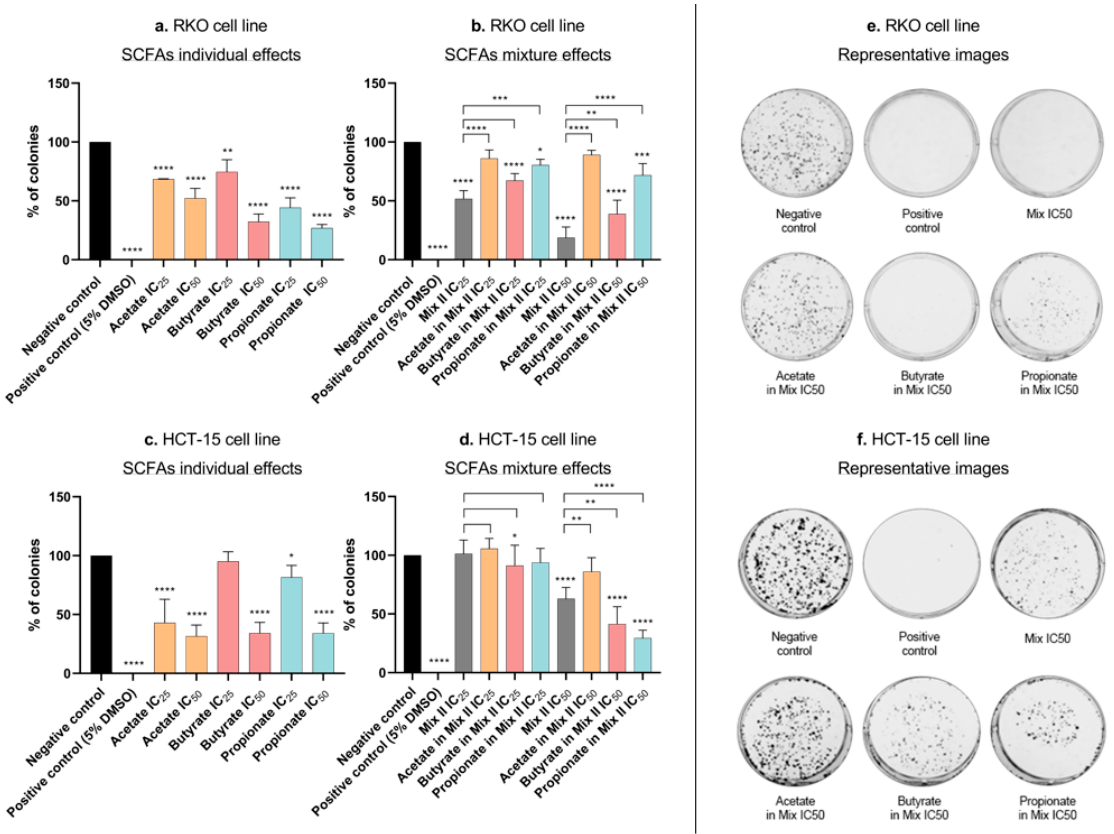
highest concentration of mixture also induces apoptotic cell death (Figure 5A,B). While in RKO this seems to be due mostly to acetate effects (Figure 5b), in HCT-15 this is correlated with the effects induced by the butyrate and propionate at the concentration present in the mixture (Figure 5d).